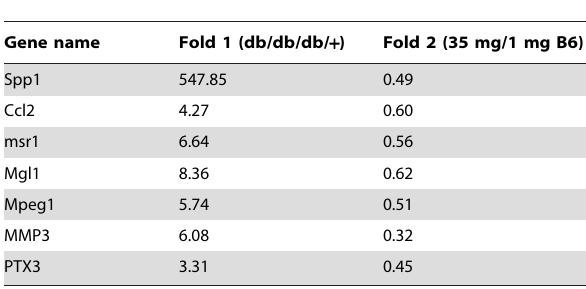
DNA microarray analysis was repeated with the Cy3 and Cy5 dyes reversed (a dye swap). Fold change ( Fold 1 ) represents the average of mRNA expression level in db/db mice relative to db/ + mice. Fold change ( Fold 2 ) represents the average of mRNA expression level in mice with a 35 mg PN HCl/kg diet relative